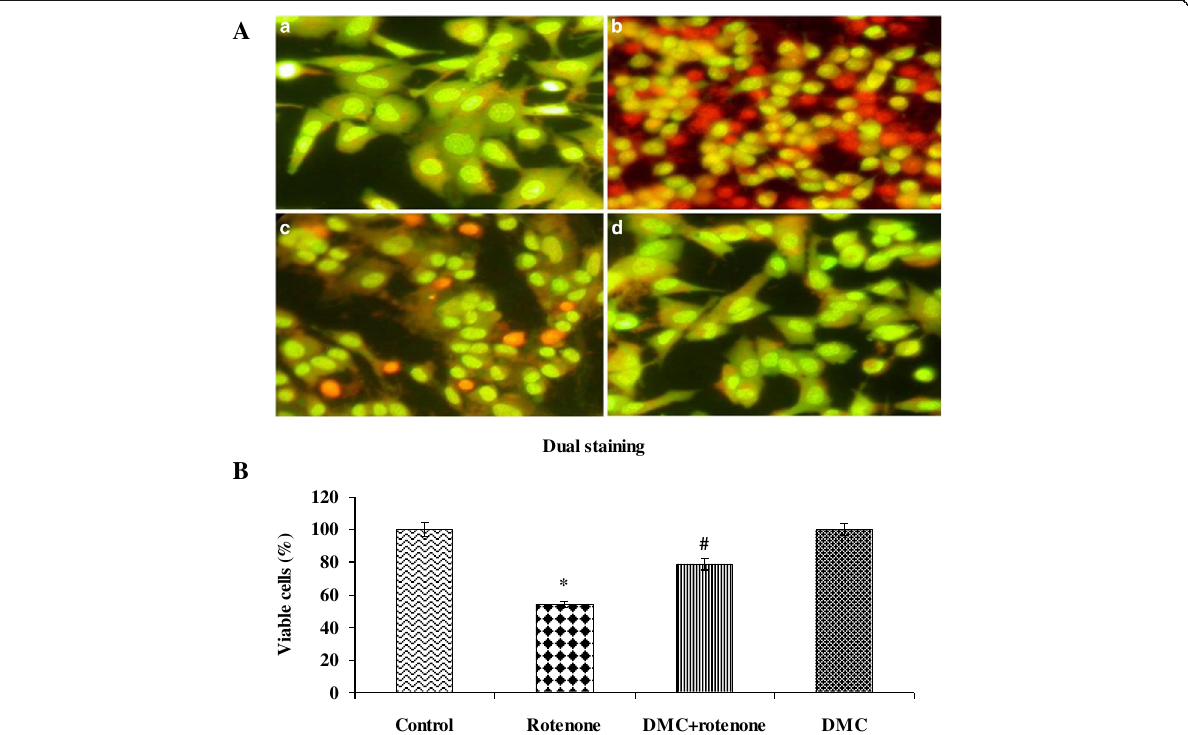
Fig. 6 DMC protects SH-SY5Y cells against rotenone induced apoptosis. a Photomicrograph showing the antiapoptotic effect of DMC (50 nM) against rotenone at a concentration of 100 nM effective dose. a Control, b rotenone, c DMC + rotenone, and d DMC. b Rotenone (100 nM) treatment induced cell apoptosis compared to control cells; pretreatment with DMC (50 nM) suppresses these apoptotic features. Values are given as mean ± SEM of four independent experiments in each group. * p <0.05 compared to control and # p <0.05 compared to rotenone group